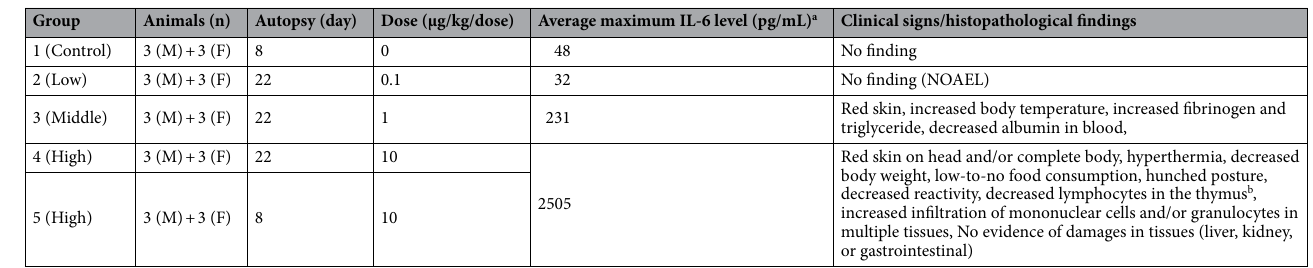
Red skin, increased body temperature, increased fibrinogen and triglyceride, decreased albumin in blood, Red skin on head and/or complete body, hyperthermia, decreased body weight, low-to-no food consumption, hunched posture, decreased reactivity, decreased lymphocytes in the thymus b , increased infiltration of mononuclear cells and/or granulocytes in 5 (High) multiple tissues, No evidence of damages in tissues (liver, kidney, or gastrointestinal) Table 1. Summary of safety study of ERY974 in cynomolgus monkeys. The symptoms, level of cytokines in the blood, clinical pathological and histopathological findings in animals after administration of ERY974 are summarized. The level of IL-6 has been previously described 8 . a 8 h after administration. b Observed on both day 8 and 22 autopsy samples. M male, F female, NOAEL no observed adverse effect level.